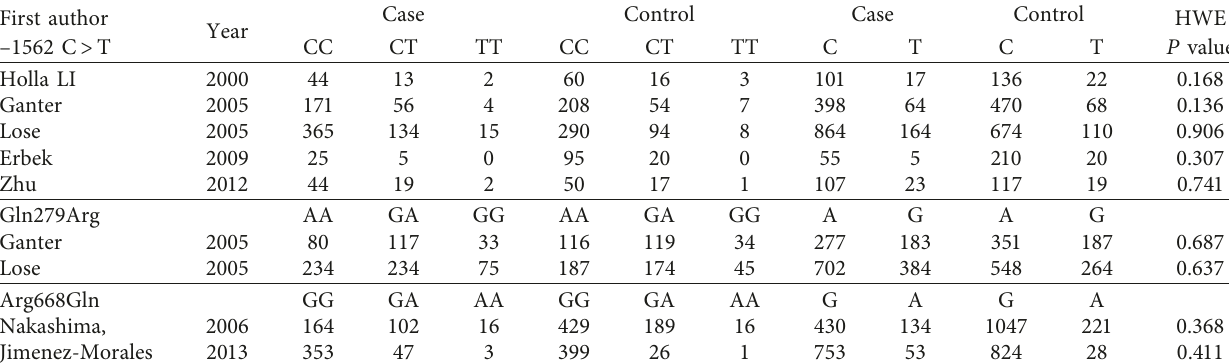
Table 2: Genotype and allele distribution of MMP-9 polymorphisms in the